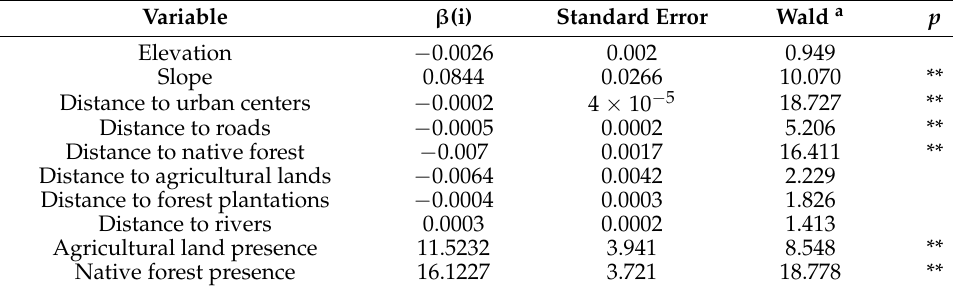
Table 1. Logistic regression parameters fitted for forest expansion